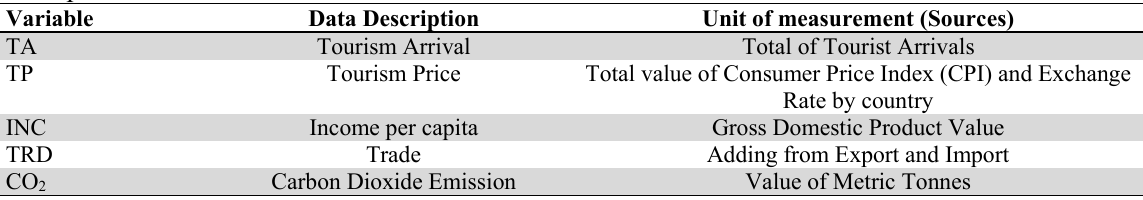
Description and unit of the data